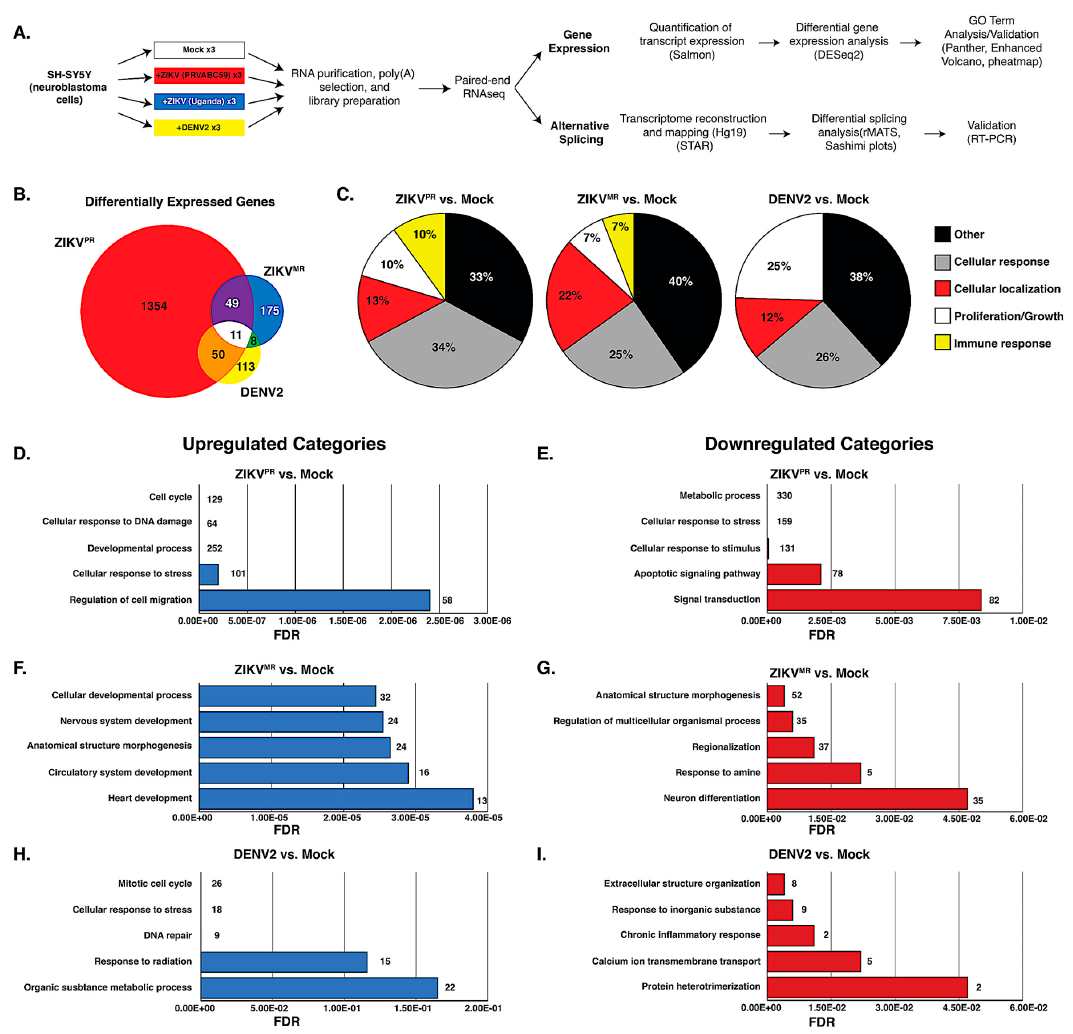
Figure 2. Transcriptome analysis of mock- and virus-infected SH-SY5Y cells. ( A ) Schematic showing the pipeline from cells to differential gene expression and alternative splicing analysis. ( B ) Venn diagram of differentially expressed (DE) transcripts between cells infected with different viruses versus mock-infected SH-SY5Y cells. DE transcripts from ZIKV PR versus mock, ZIKV MR versus mock, and DENV2 versus mock are highlighted in the red, yellow, and blue circles, respectively. ( C ) All differentially expressed genes for each condition were input into ShinyGO(2.0), and the top 25 biological GO terms were categorized into five types, with the distribution of each type presented in a pie chart. ( D , F , H ) Top five functional categories derived from statistically significant upregulated genes for the indicated condition. ( E , G , I ) Top five functional categories derived from statistically significant downregulated genes for the indicated condition. GO terms are annotated on the y-axes, and false discovery rates (FDR) are represented on the x-axes.